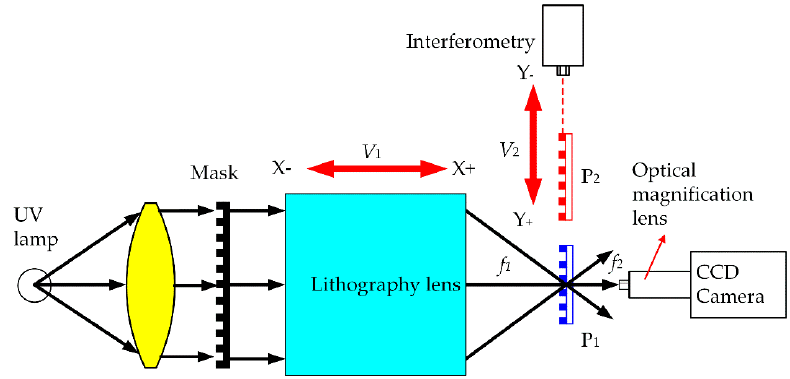
Figure 1. Scheme of the system for the accuracy alignment in projection lithography.